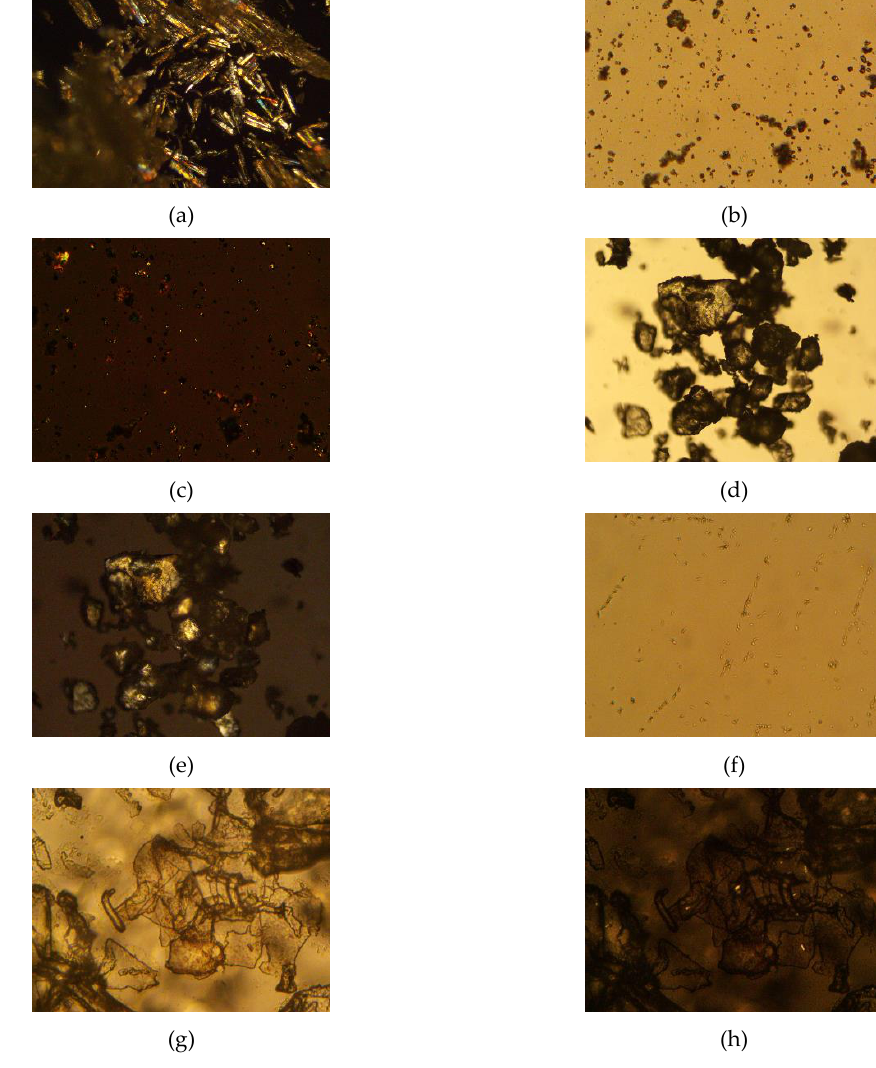
Figure 3. Photomicrographs of raw materials and processed samples; ( a ) stearic acid raw material, 100x, polarized light (crossed polars); ( b ) progesterone raw material, 500×, non-polarized light (open polars) and ( c ) progesterone raw material, 500×, polarized light (crossed polars); ( d ) trehalose didydrate raw material, 100×, non-polarized light (open polars) and ( e ) trehalose didydrate raw material, 100×, polarized light (crossed polars); ( f ) progesterone-loaded stearic acid SLNs, 500×, polarized light (crossed polars); ( g ) progesterone-loaded stearic acid SLNs lyophilized in 5% trehalose solution, 500×, non-polarized light (open polars) and ( h ) progesterone-loaded stearic acid SLNs lyophilized in 5% trehalose solution, 500×, polarized light (crossed polars).